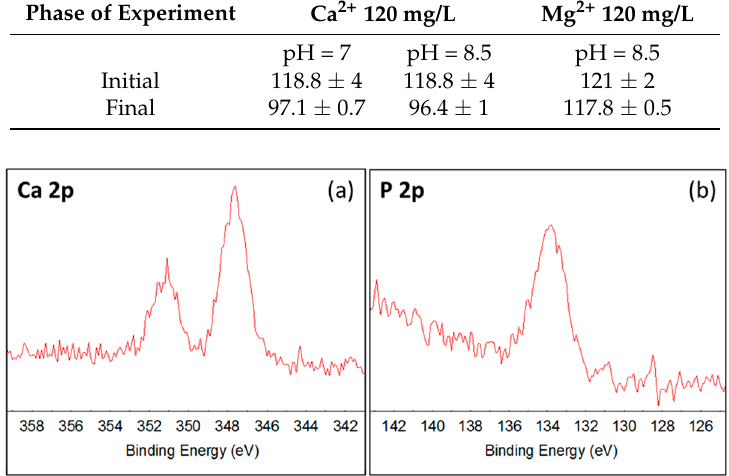
Figure 3. XPS core level spectra for ( a ) Ca 2p and ( b ) P 2p from an N-doped TiO 2 coating deposited on an 800 nm pore size membrane exposed to CaSO 4 · 2H 2 O (120 mg/L Ca 2+ ) and 1 mM phosphate buffer solution.